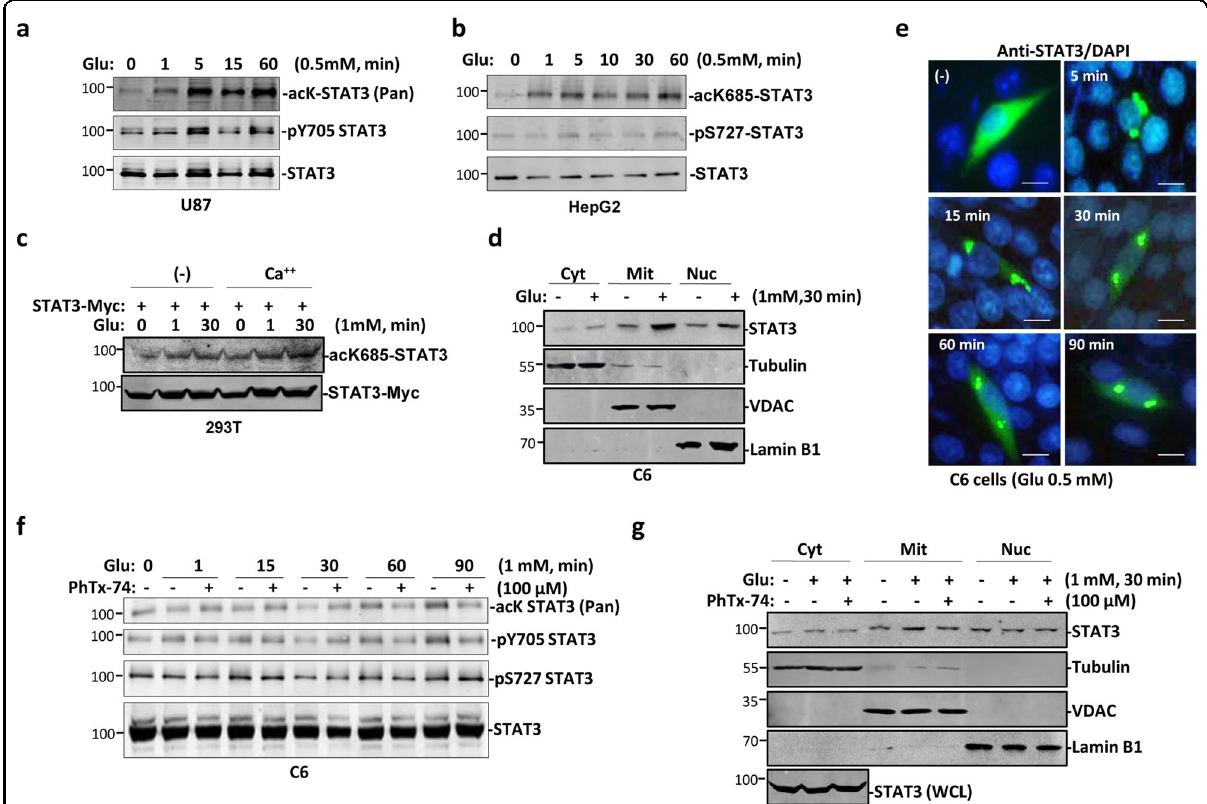
Fig. 4 Glutamate-stimulated translocation of STAT3 into mitochondria. a , b U87 a and HepG2 b cells were treated with glutamate, followed by western blot with indicated antibodies. Data shown are representative of two independent experiments. c 293 T cells were transfected with STAT3 and treated with either calcium or glutamate, or both. Cells were lysed and blotted with indicated antibodies. Data shown are representative of three independent experiments. d C6 cells were treated with or without glutamate and followed by fractionation of cell. Cells were lysed and blotted with indicated antibodies. e C6 cells were treated with glutamate for different time, and then cells were immunostained with anti-STAT3 antibody. Cells were countstained with DAPI. Scale bar: 10 μ m. Data shown are representative of two independent experiments. f C6 cells were treated with different combination of glutamate and PhTX-74. Cells were lysed and blotted with indicated antibodies. g C6 cells were treated with different combination of glutamate and PhTX-74. Cells were then lysed and fractionated, and blotted with indicated